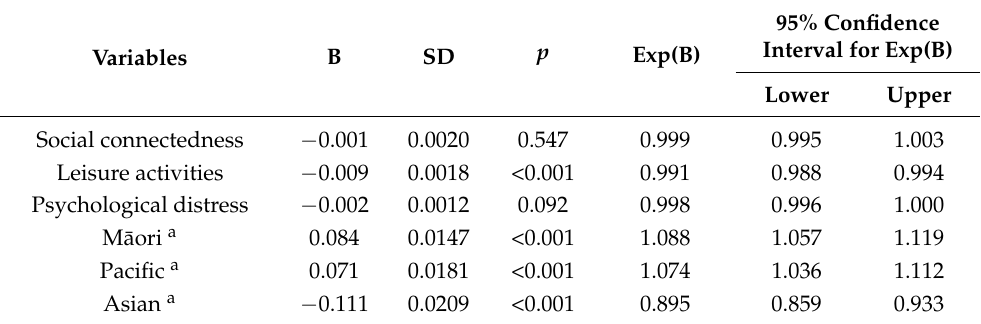
Table 3. Poisson regression results—frequency of gambling count, social connectedness, leisure activities, psychological distress, and ethnicity.